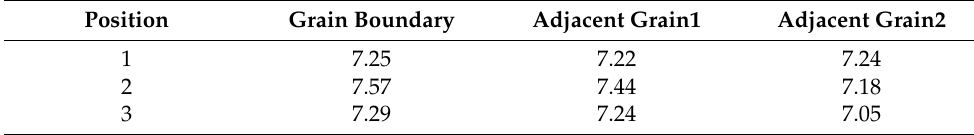
Table 2. Charges in the occupancy of the 3d state for Fe calculated according to EELS. Position Grain Boundary Adjacent Grain1 Adjacent Grain2